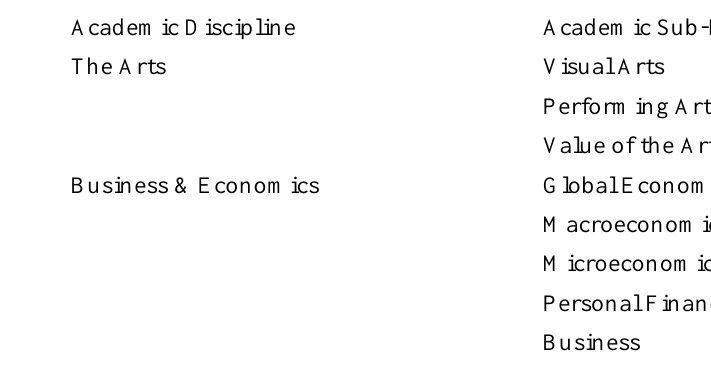
TED-Ed’s Twelve Academic Disciplines and Sixty Academic